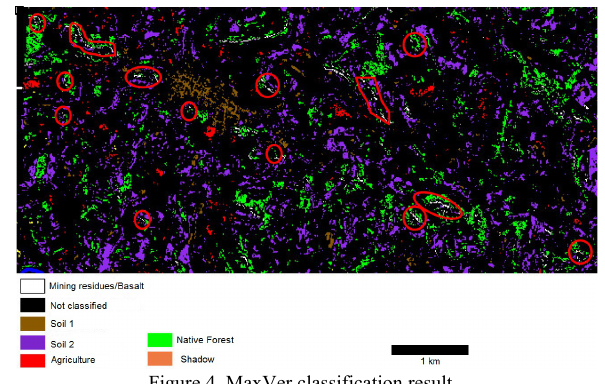
Figure 4. MaxVer classification result.